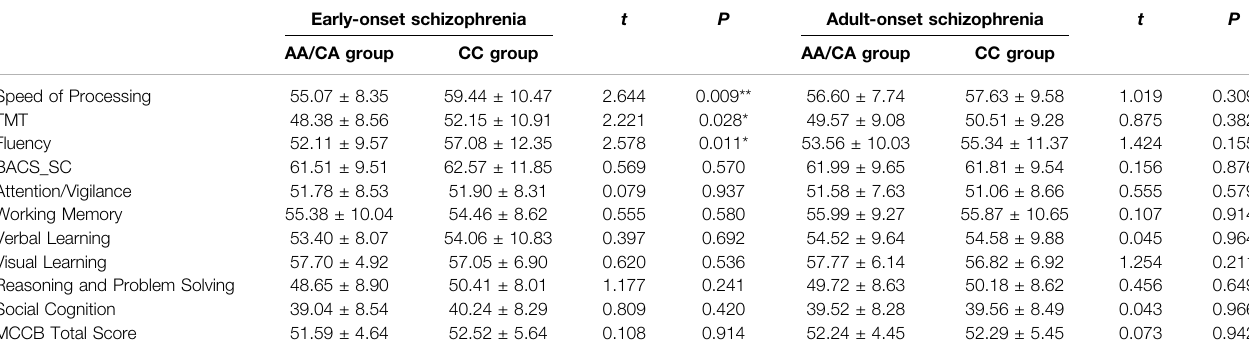
TABLE 2 | Association analysis of rs1635 with MCCB cognitive